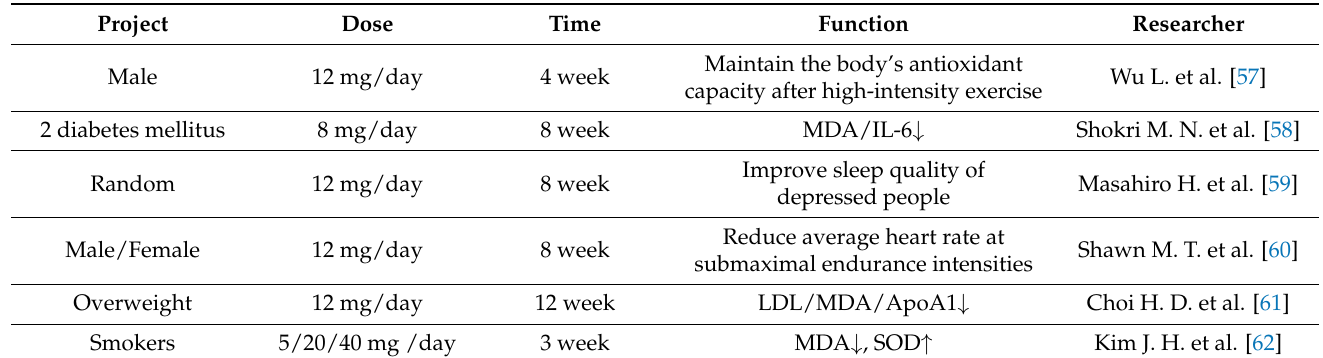
Table 2. Research on Astaxanthin in Human